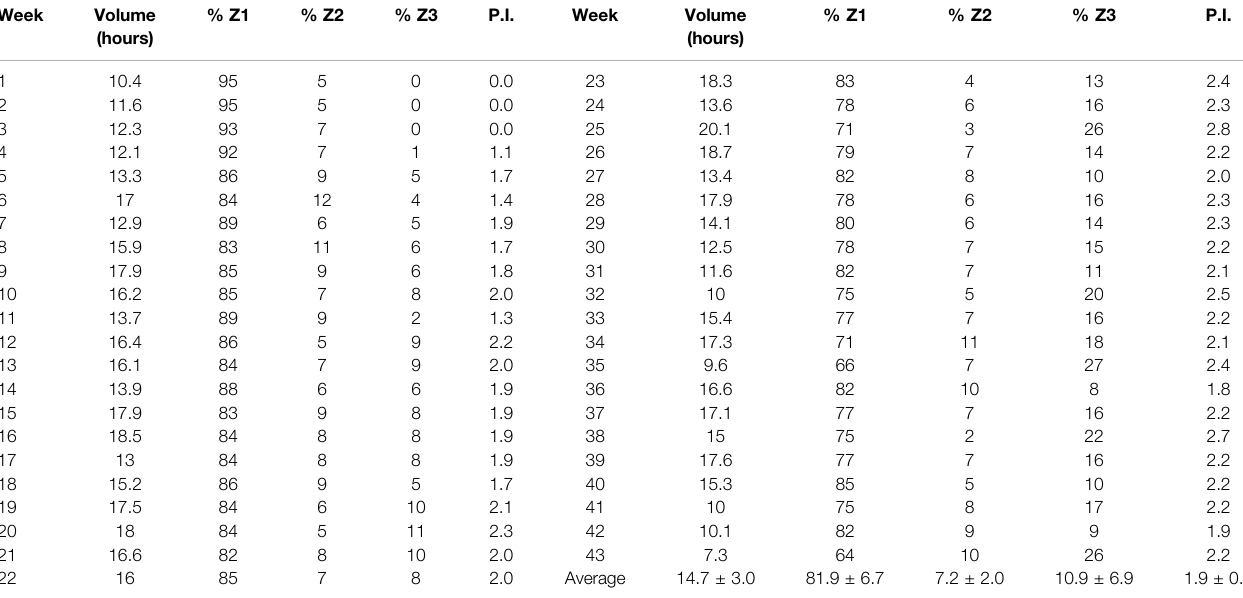
TABLE 1 | Weekly training volume and training intensity distribution (triphasic model).